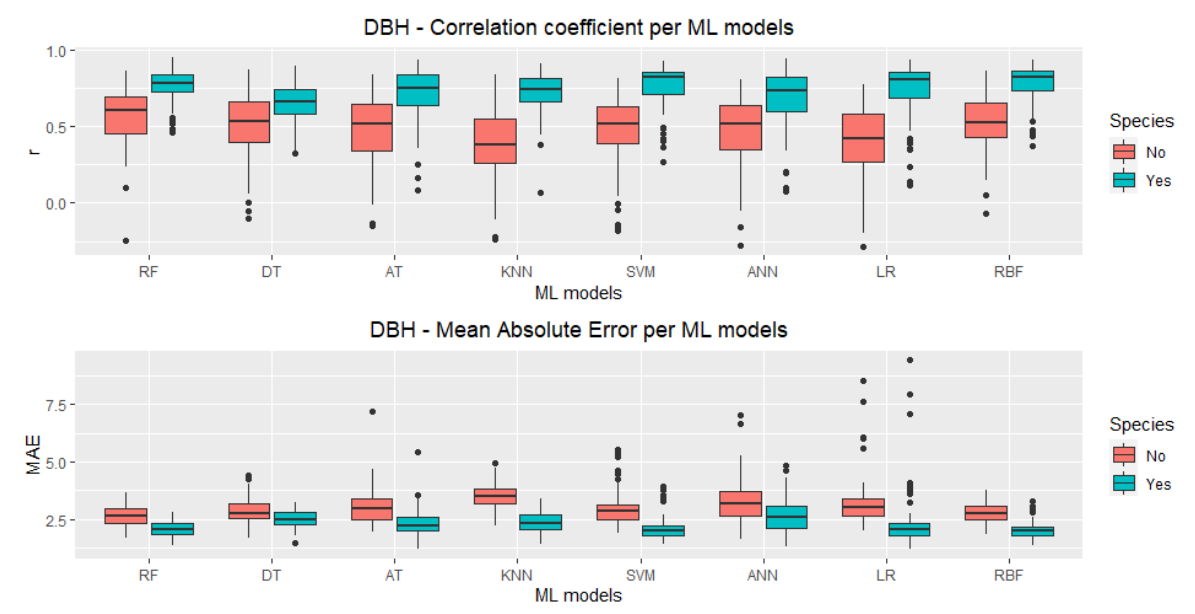
Figure 3. Boxplots for Pearson’s correlation coefficient ( r ) and DBH-mean absolute error (MAE) using all VIs, for these machine learning models: Random Forest (RF), REP Tree (DT), Alternating Model Tree (AT), K-Nearest Neighbours (KNN), Support Vector Machine (SVM), Artificial Neural Networks (ANN), Linear Regression (LR) and Radial Basis Functions